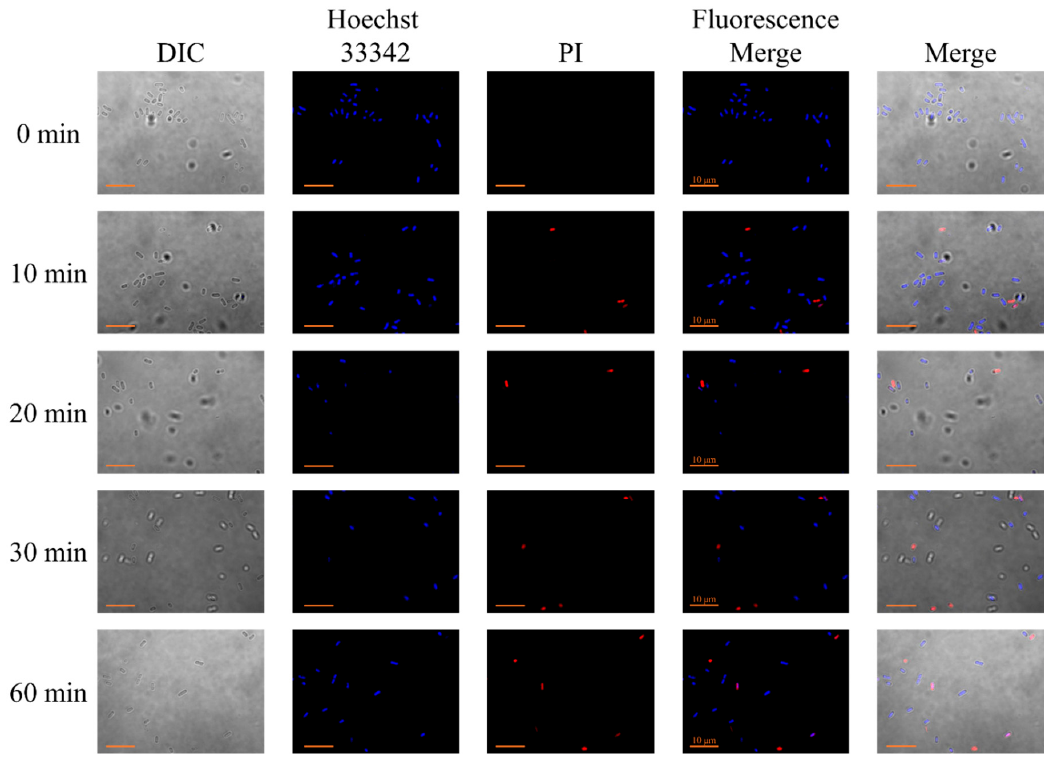
Figure 4. Cell membrane integrity of MDR ETEC treated with Q4-15a-1 of 4× MIC (16 μ g/mL) for 10, 20, 30, or 60 min monitored by confocal microscopy. Bar: 10 μ m.